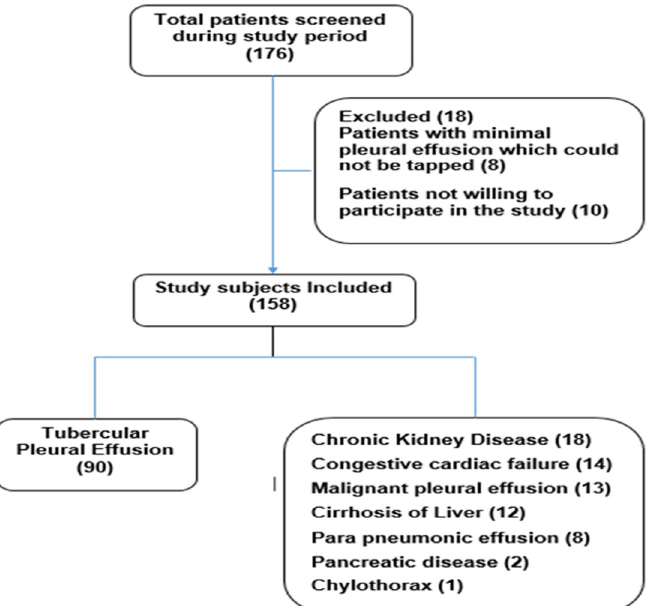
Fig 1. Flow chart of the study